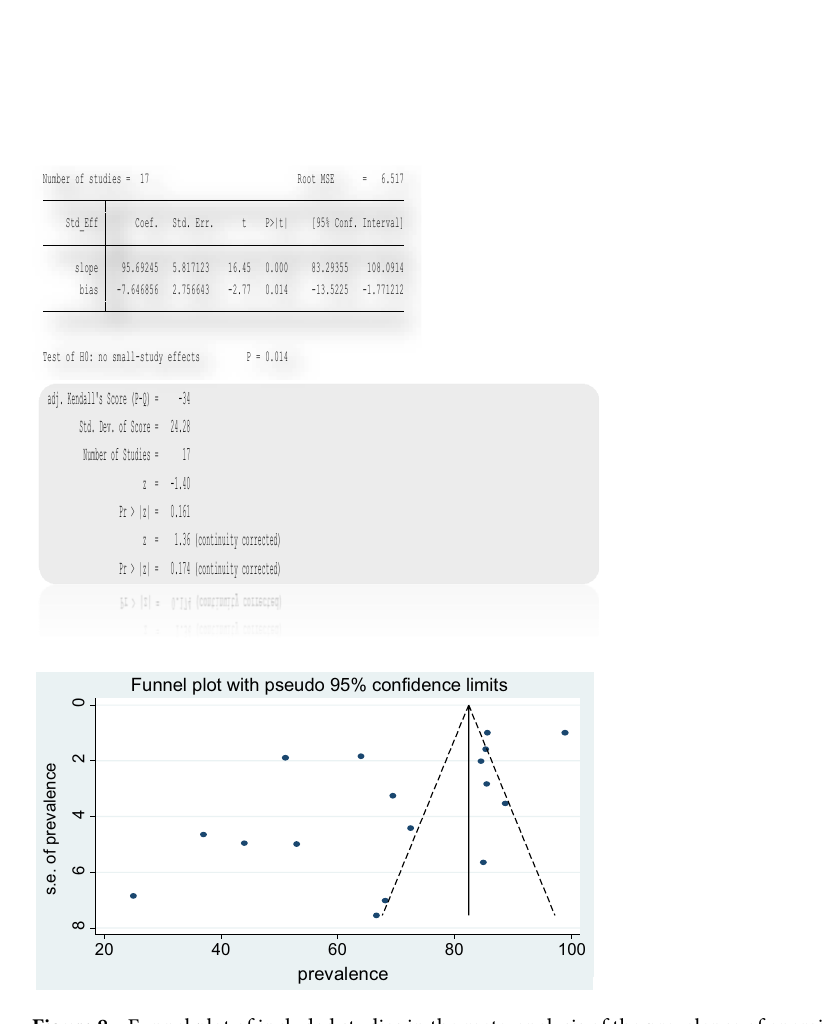
Figure 8. Funnel plot of included studies in the meta-analysis of the prevalence of anemia in